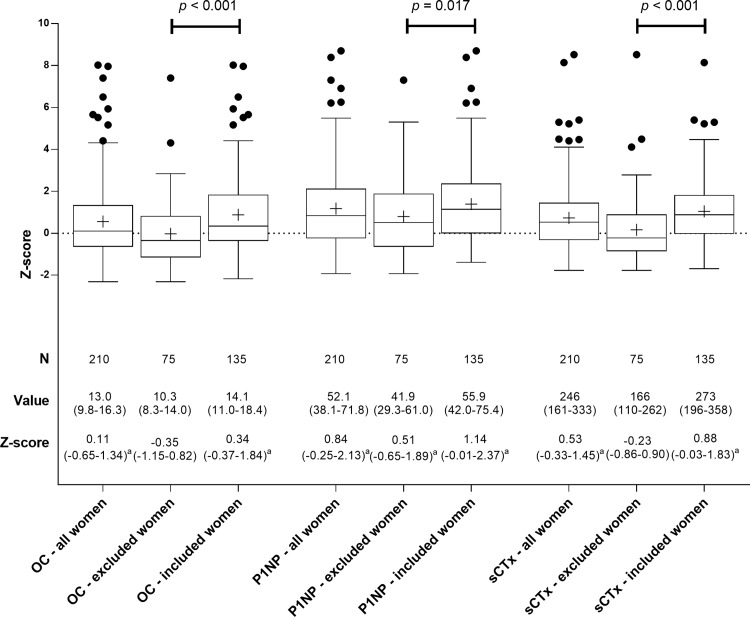
Levels of Osteocalcin, PINP and sCTx after RRSO in all women (N = 210), excluded women with recent fractures or currently using HRT or AI or ever using AOD (N = 75) and women included for regression analyses (N = 135).Box-and whisker plots (Tukey): boxes indicate medians with interquartile ranges; + indicate means; whiskers indicate 1.5 times the interquartile distances; ∙ indicate outliers. a. p < 0.05; median Z-scores are compared to a median Z-score of 0.